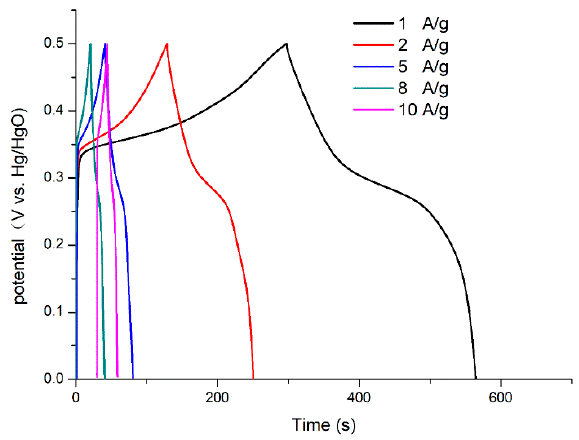
ff erent current